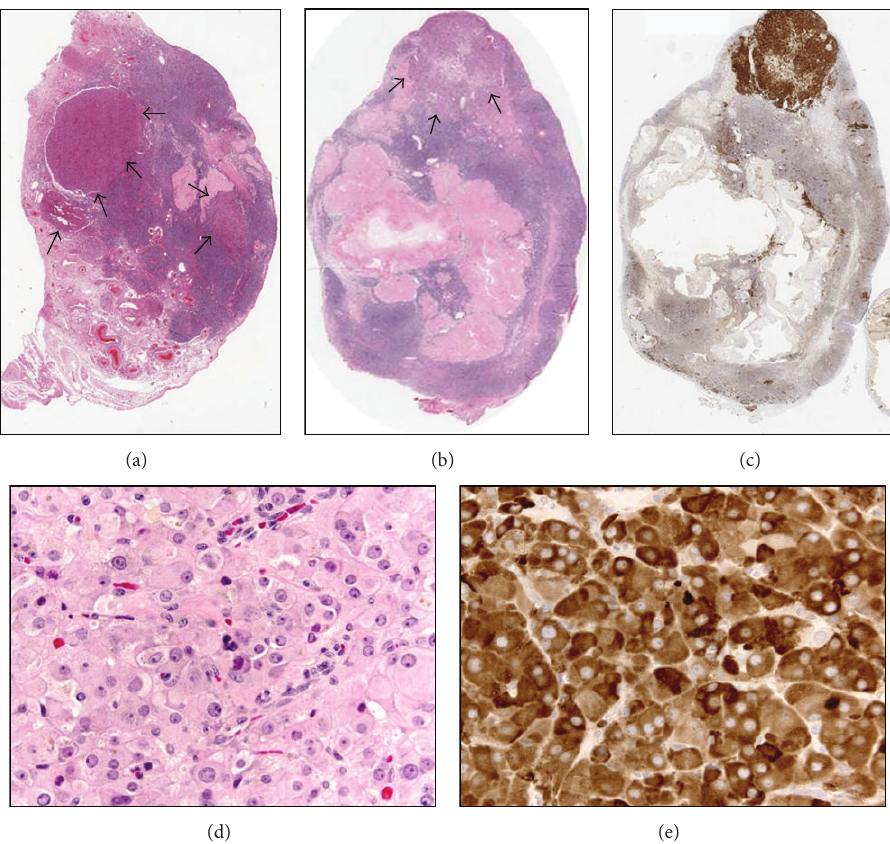
Figure 1: Whole-slide sections of left (a) and right (b) ovaries display multiple eosinophilic nodules of Leydig cells (arrows). Immunohistochemistry for inhibin A highlights the nodules and identifies additional small clusters of Leydig cells (c, whole-slide section, right ovary). The nodules are composed of Leydig cells, which are polygonal with abundant granular eosinophilic cytoplasm and large vesicular nuclei (d, H&E, 400x). The Leydig cells display strong cytoplasmic staining with inhibin A (e,